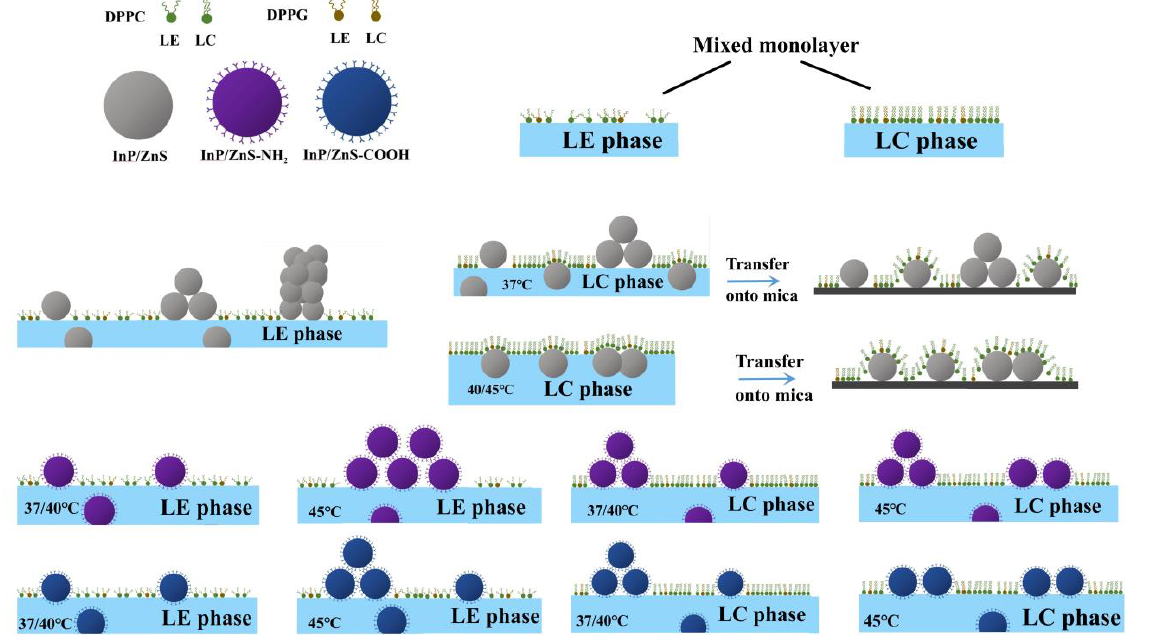
Figure 5. Diagram of interaction between three types of InP/ZnS nanoparticles and the DPPC/DPPG mixed monolayers. Table 3. The distribution of nanoparticles on the LE and LC phase of the DPPC/DPPG monolayer.